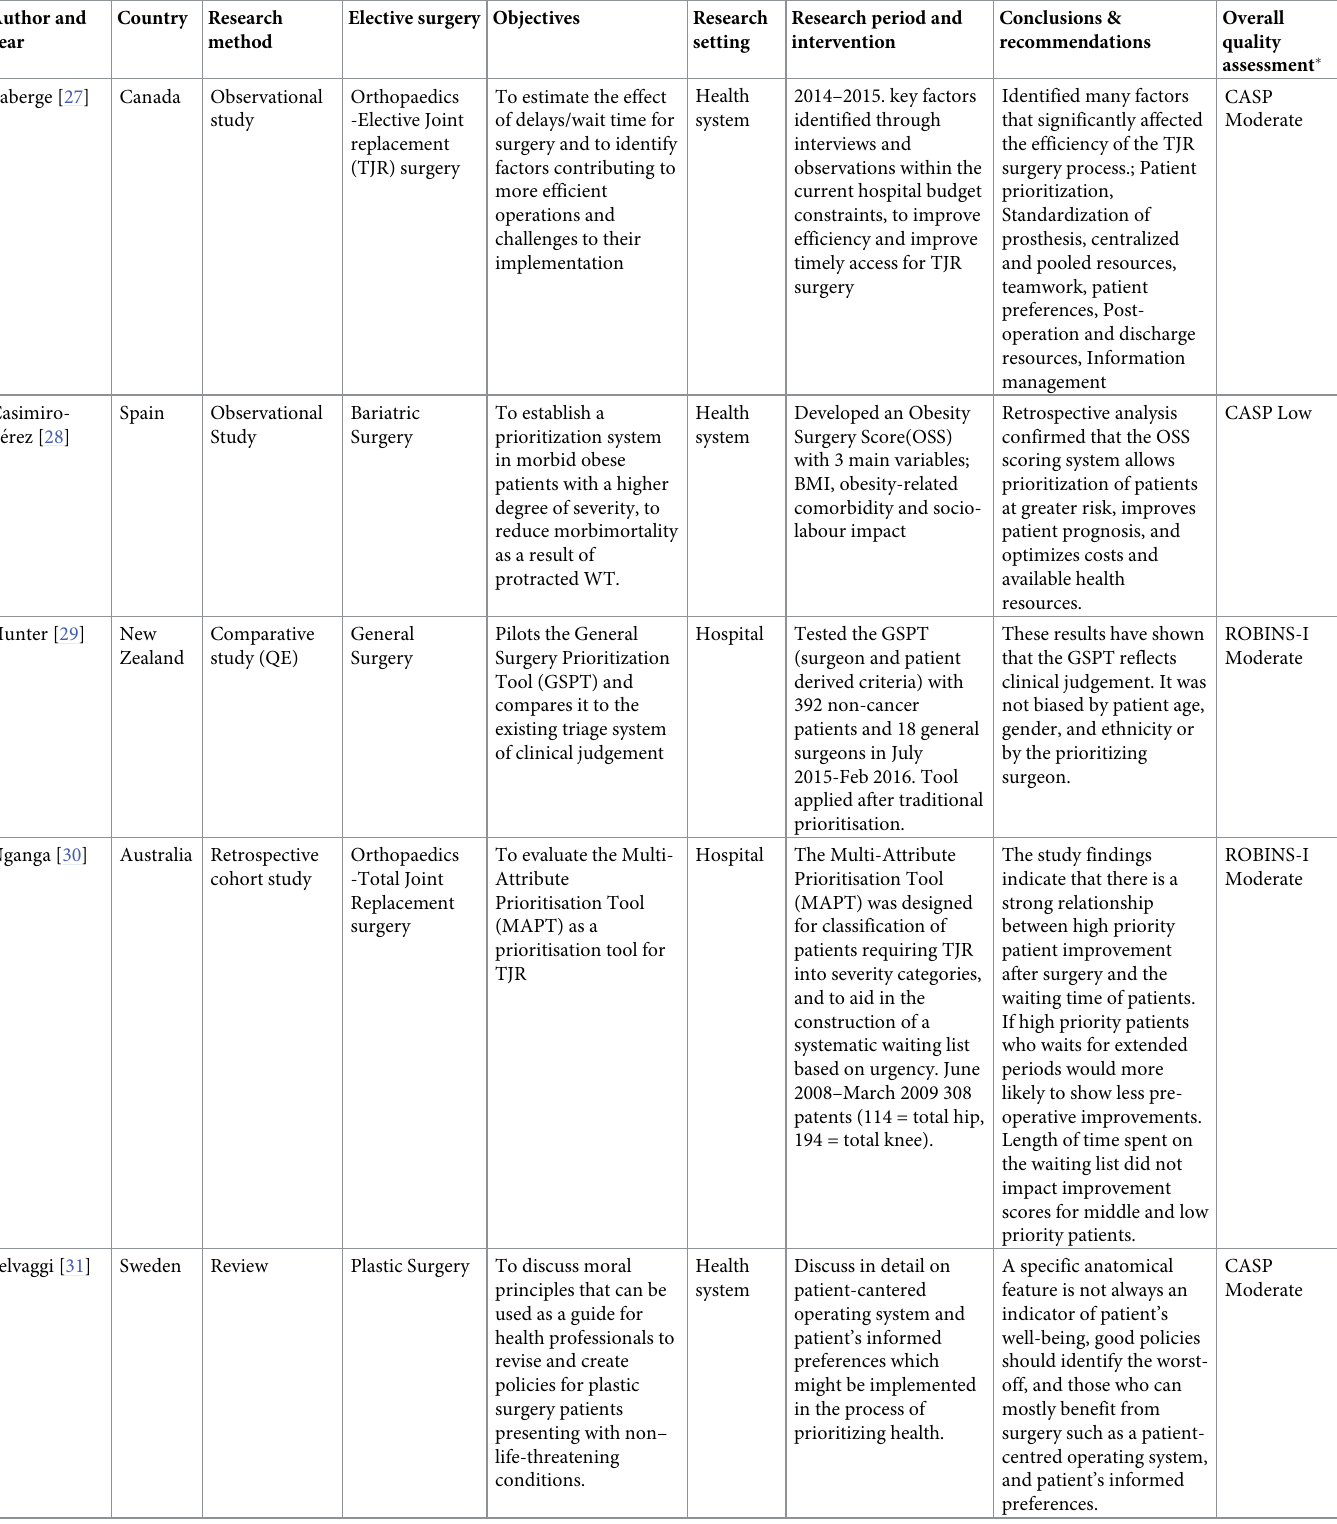
Table 2. Descriptive characteristics of the seventeen studies included for the review and their overall quality